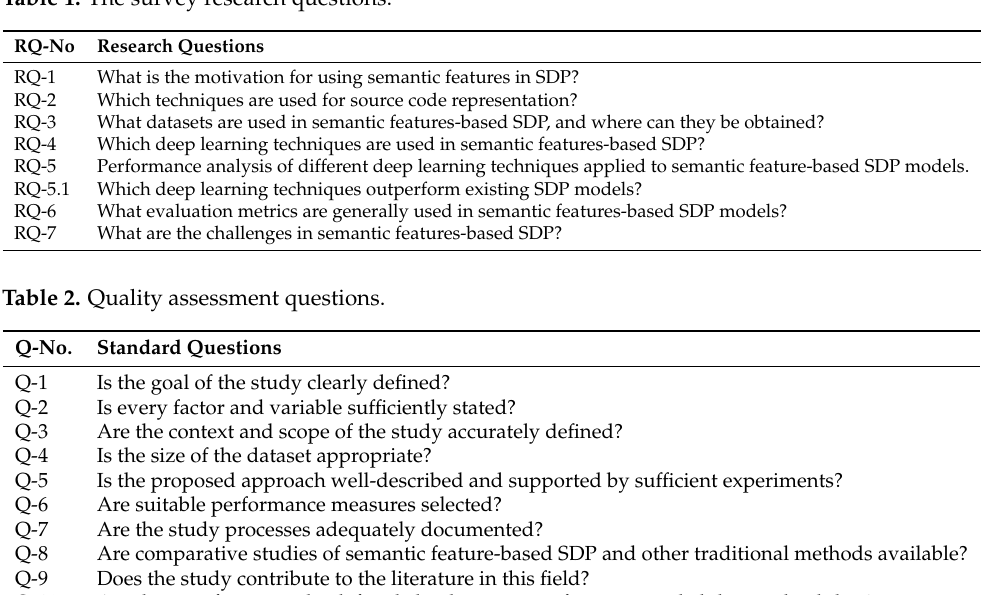
Table 1. The survey research questions.